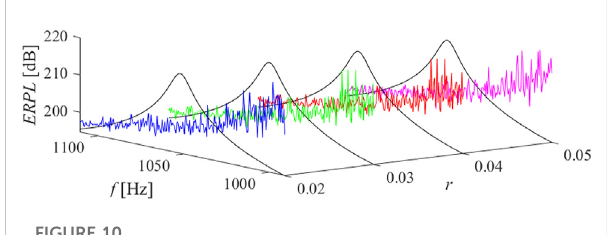
FIGURE 13 ERPL around the third mode of resonance, n = 5, ̶ short circuit, ̶ r = 0.02, ̶ r = 0.03, ̶ r = 0.04, ̶ r =